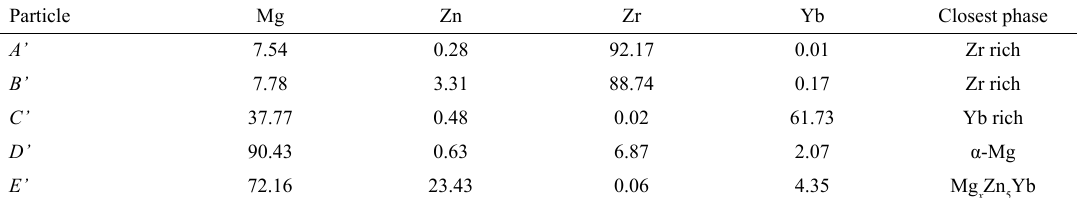
Table 2. Compositions of particles within the 380 homogenized samples (see Figure 8c) measured by EDS (at.%). Particle